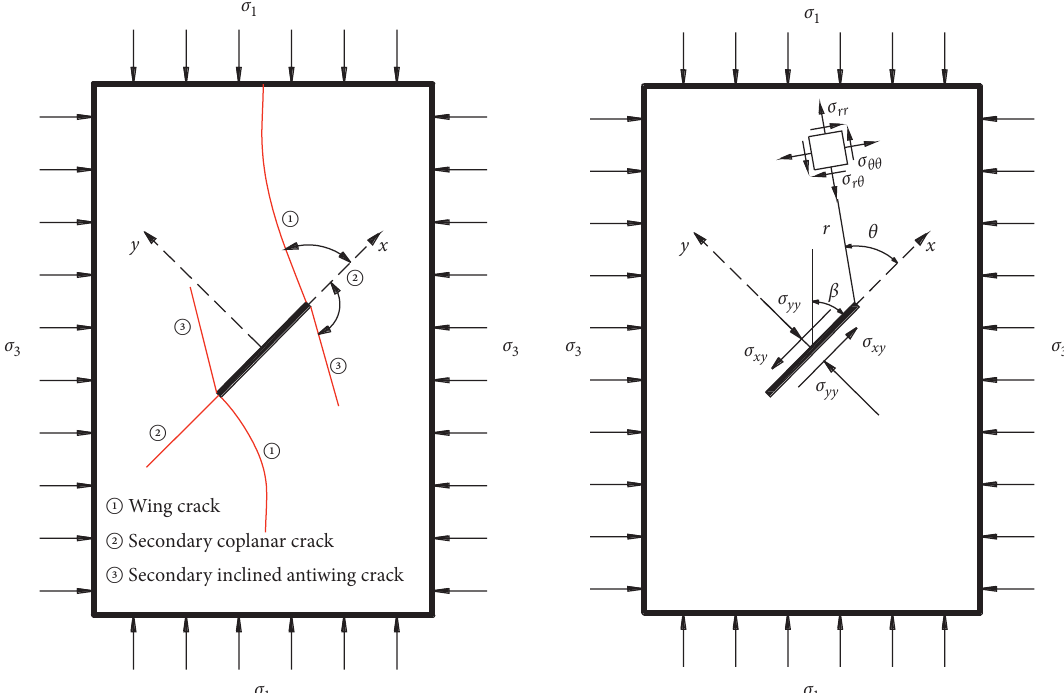
Figure 1: Types of crack propagation and the mechanical model: (a) typical morphology of crack propagation; (b) mechanical